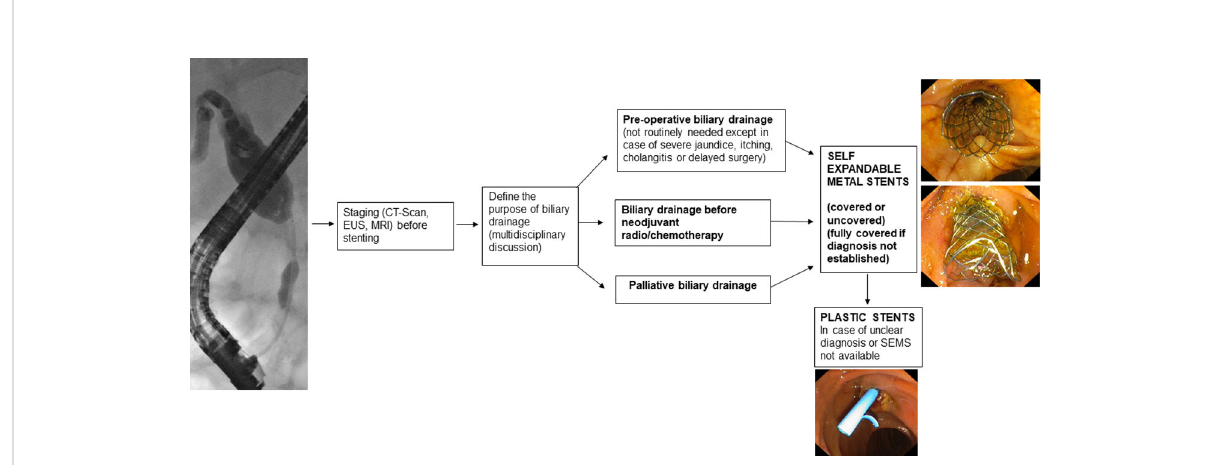
FIGURE 1 Malignant bile duct strictures and choice of the